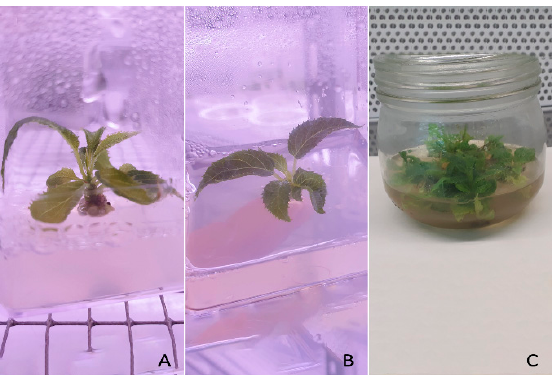
Figure 7. In vitro culture of the regenerated plantlets. ( A ) Non-edited line A0134.41_L8 on elongation medium. ( B ) Edited line Ac174.46_L1 on elongation medium. ( C ) Edited line A0134.41_L3 propagated on shoot induction and maintenance medium.